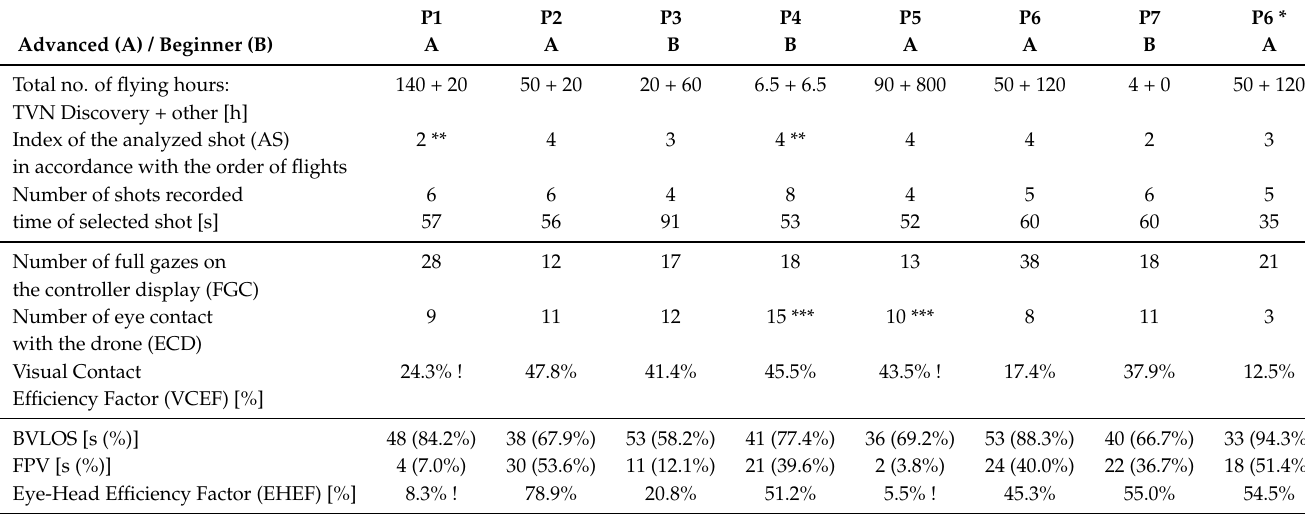
video material in three separate files. The number appearing in the center of the screen indicates the start and end of the shot and its number. Table 2. Results of eye-tracking and video-analytical research; Source: own study.